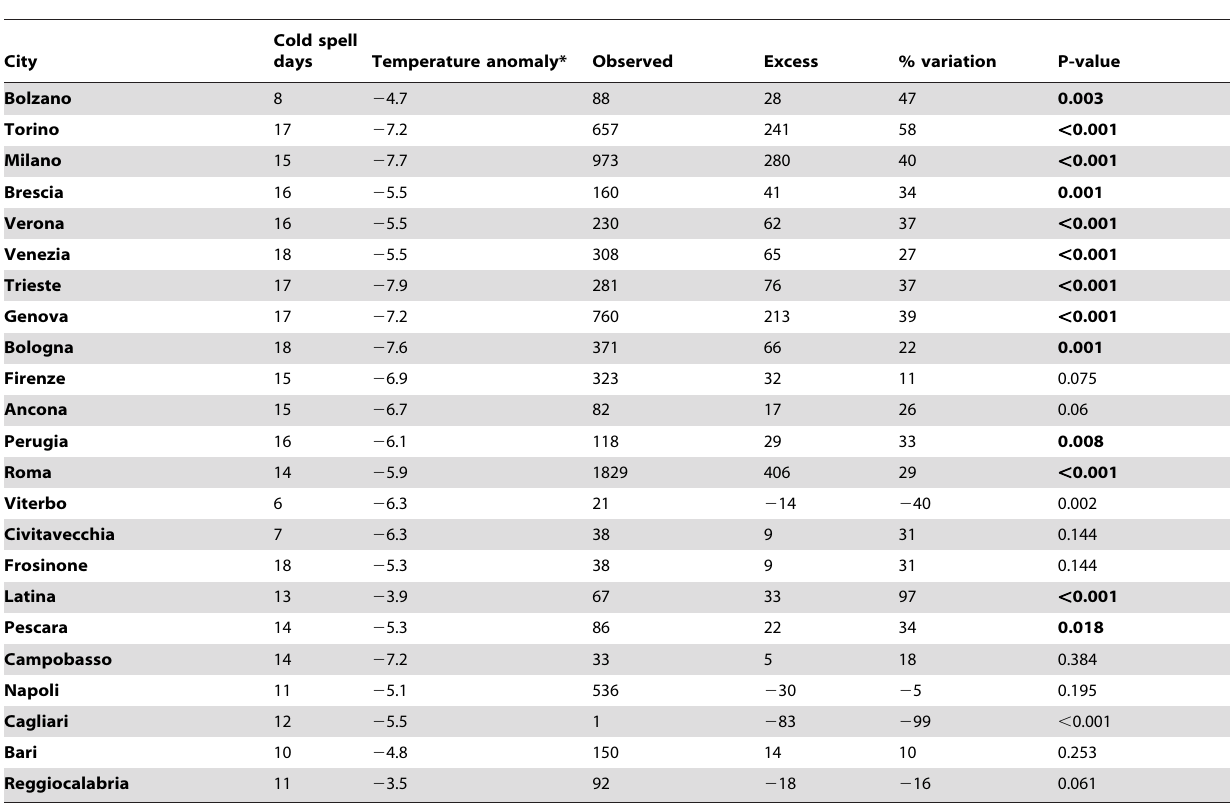
Table 1. Observed, excess and percent variation in mortality among the very old (75 years and over) during the February 2012 cold spell episode in Italian